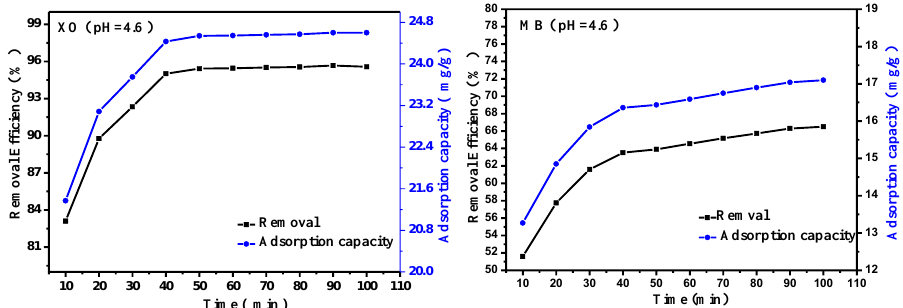
Figure 7. Effect of contact time on the dye removal efficiencies of XO and MB (initial dye concentration: 30 mg L − 1 ,60 mL MB or XO solution, 70 mg adsorbent, 10–100 min, pH = 6.8 or 4.6). Table 3. Kinetic parameters for the adsorption of XO and MB onto PEI–TORC. Pseudo-First Order Model Pseudo-Second Order Model